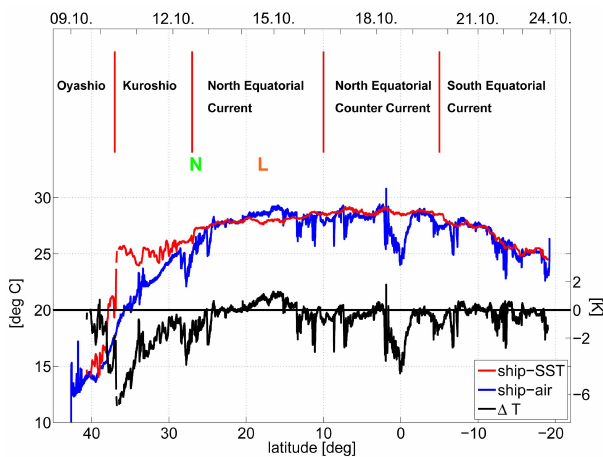
Fig. 2. Sea surface temperature ( ◦ C), surface air temperature ( ◦ C) and the difference between the two ( 1T , in K) measured on board of R/V Sonne during October 2009. The measurements are dis- played as 1min averages. The identified oceanic circulations are displayed, as well as the influence of the tropical storms Nepartak (N) and Lupit